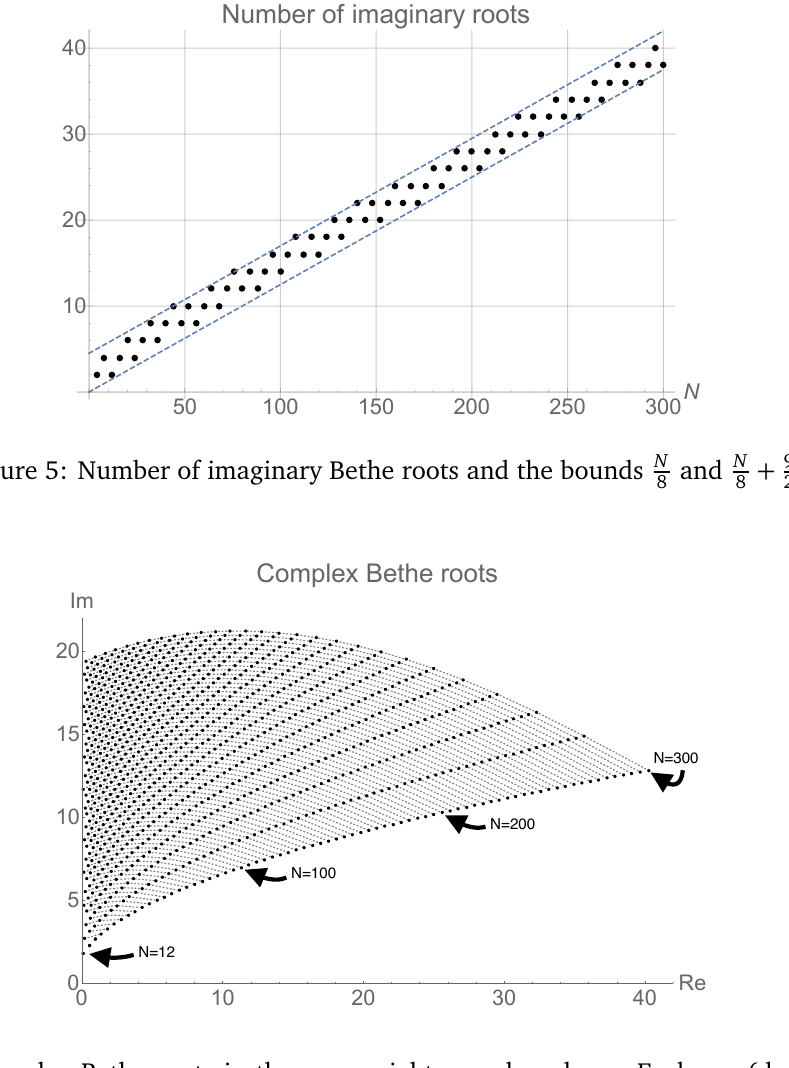
Figure 6: Complex Bethe roots in the upper right complex plane. Each arc (dashed lines) corresponds to a given N, ranging from N = 12 (lowest point) to N = 300 (highest arc). Three symmetric arcs also exist in the three other quadrants of the complex